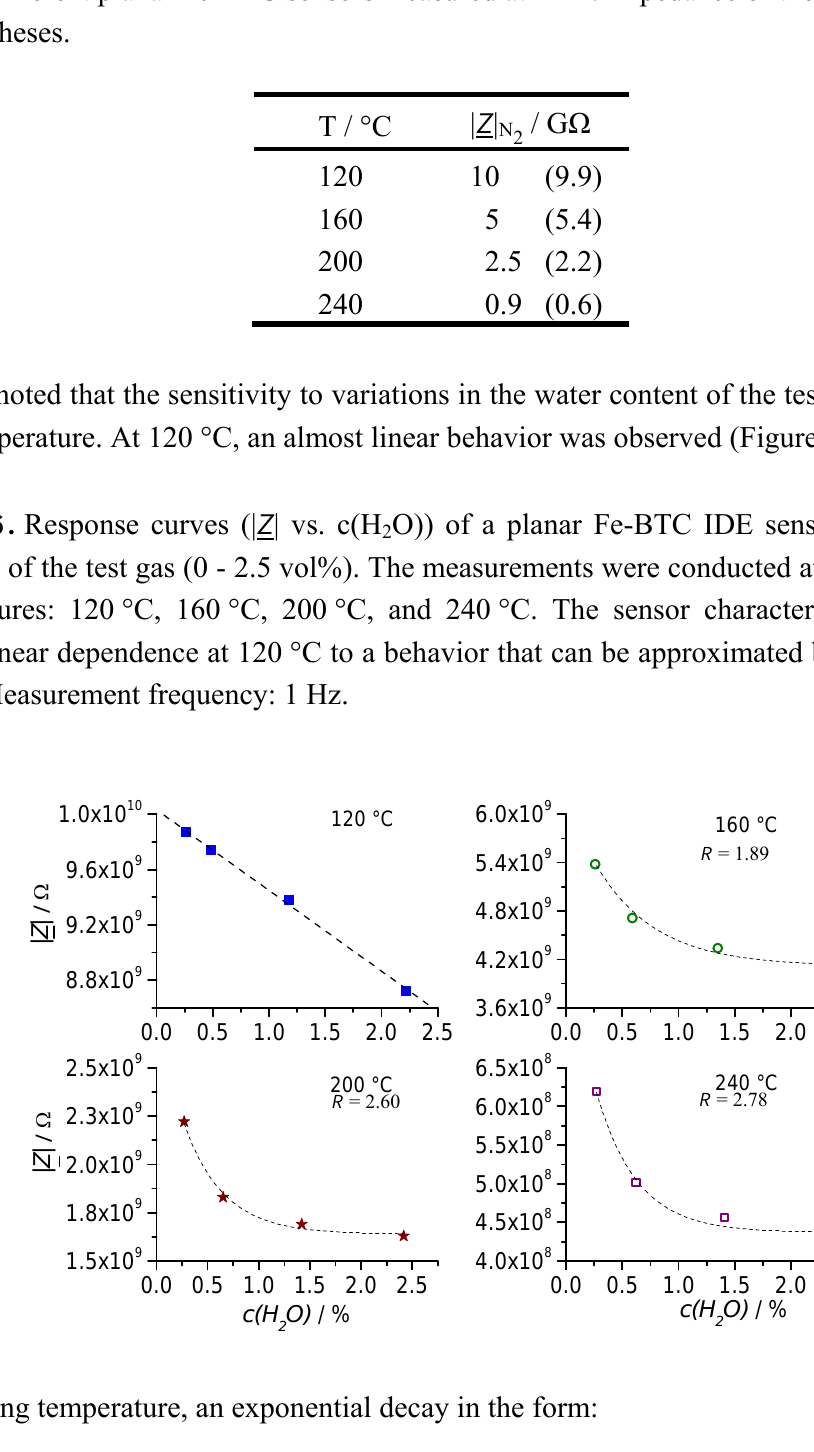
Table 2. Complex impedance | Z | in N carrier gas at different measurement temperatures 2 for two different planar Fe-BTC sensors measured at 1 Hz. Impedance of the second sensor in parentheses.